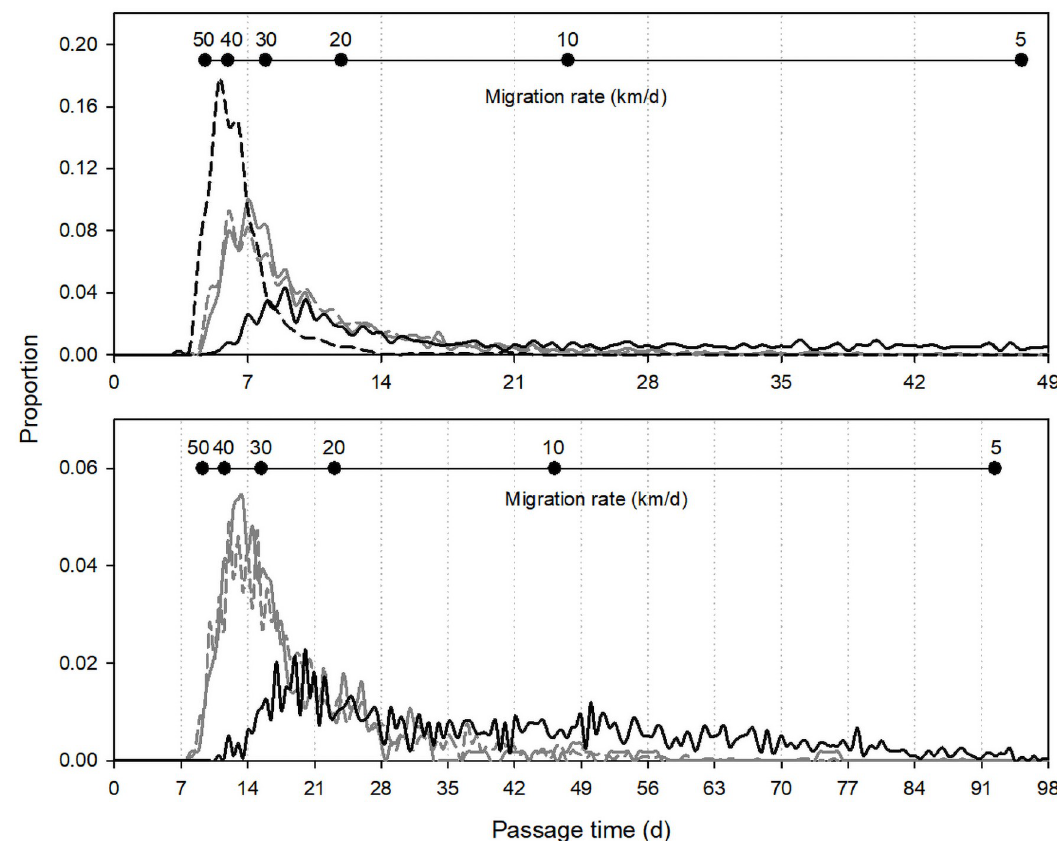
Fig 3. Distributions of radio-tagged salmon and steelhead passage times displayed as duration (d, x-axis) or as migration rates (inset scale, km/d) from first detection in the Bonneville Dam tailrace to last detections at top-of-ladder antennas at McNary Dam (top) and Lower Granite Dam (bottom). Spring–summer Chinook Salmon (dashed gray line), fall Chinook Salmon (solid gray line), Sockeye Salmon (dashed black line), and steelhead (solid black line). Times for steelhead temporarily entering tributaries between dams due to behavioral thermoregulation and those with overwintering behaviors are not shown, which included 23% (top) and 12% (bottom) of steelhead with calculated